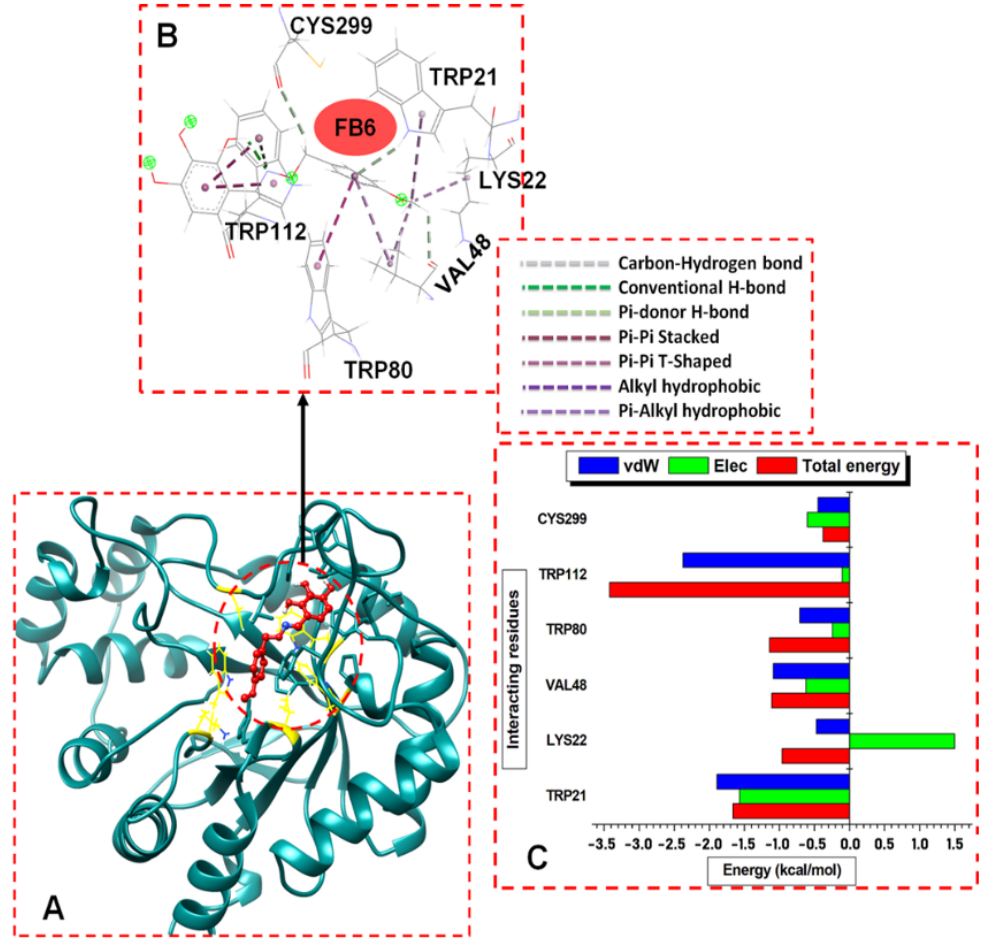
Figure 4. ( A ) Structural view of 8b (working code FB6) bound to ALR2 enzyme active site. ( B ) Visual illustration of the ALR2- 8b interaction network (color online). ( C ) Per-residue energy contributions to the ALR2- 8b complex.